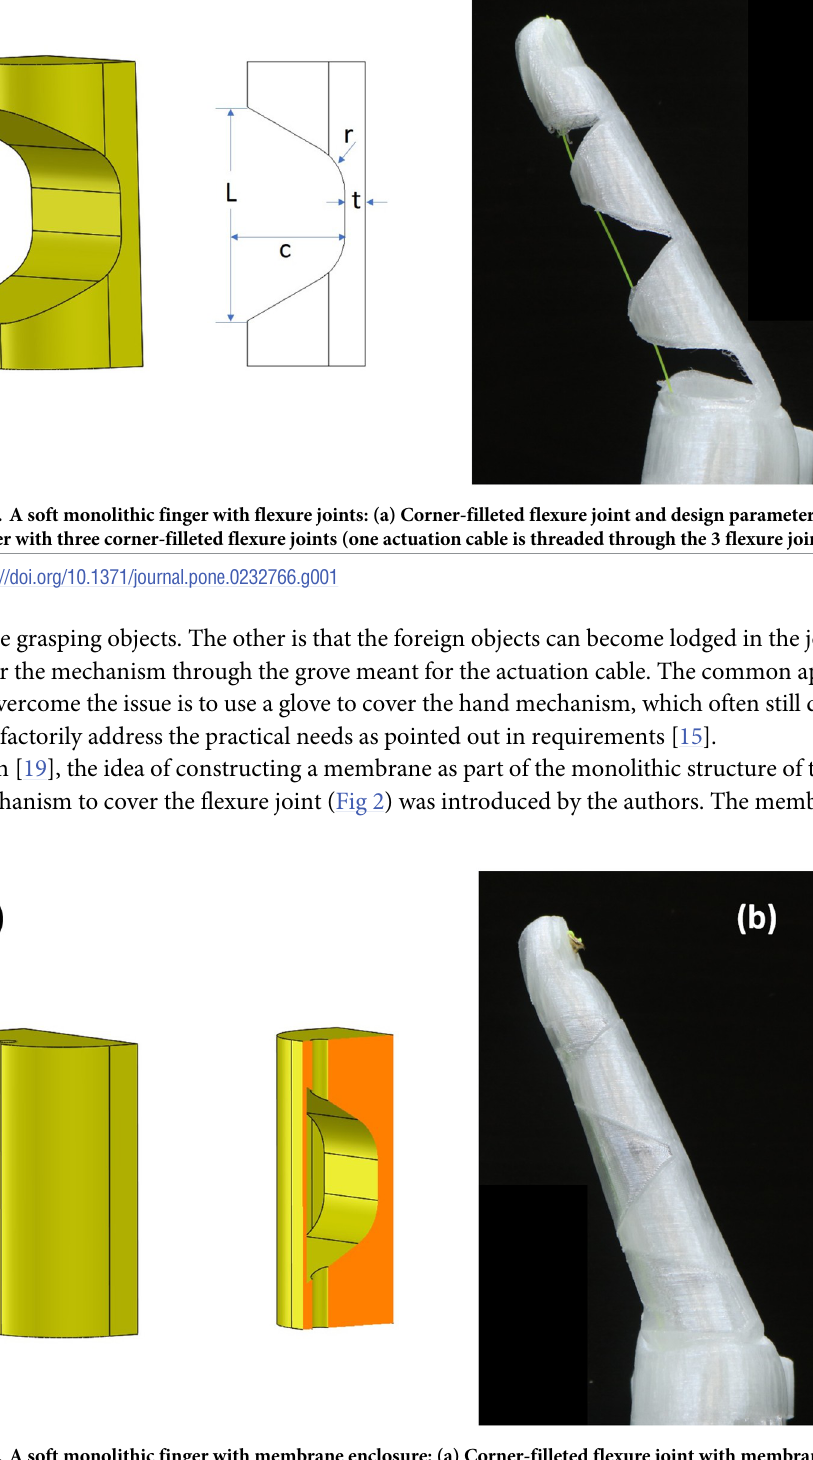
Fig 2. A soft monolithic finger with membrane enclosure: (a) Corner-filleted flexure joint with membrane enclosure; (b) Finger with three membrane enclosed flexure